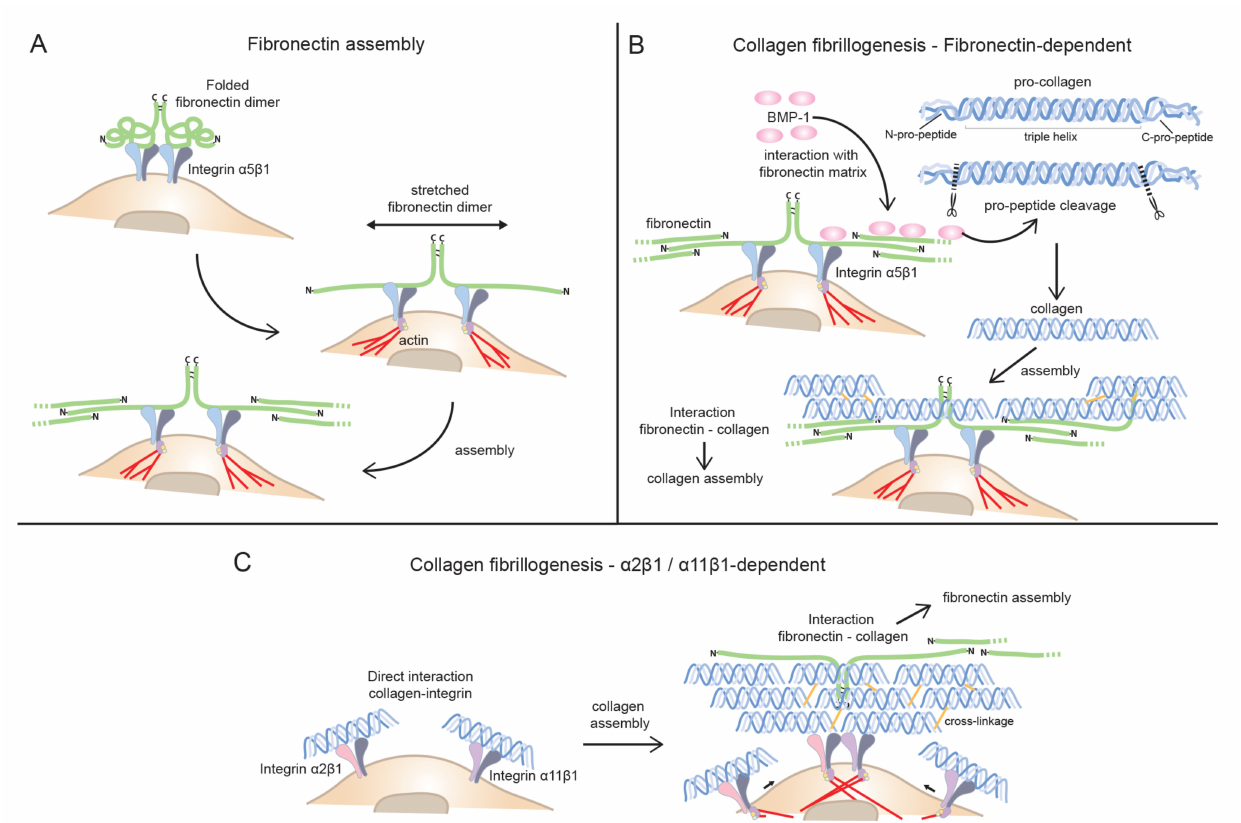
Figure 1. Collagen and fibronectin fibrillogenesis. ( A ) Fibronectin fibrillogenesis. Binding of fibronectin (FN) to the FN receptor α 5 β 1 integrin leads to a conformational change in FN exposing sites needed for fibril formation. The actin cytoskeleton exerts a pulling force on α 5 β 1 integrins to unfold FN. ( B ) Indirect mode of collagen assembly (fibronectin- dependent). Fibrillar collagens are secreted as pro-collagen. FN facilitates collagen assembly by concentrating BMP-1, which is involved in collagen pro-peptide cleavage. Collagen could then interact with FN matrix that serves as nucleator of collagen assembly. ( C ) Direct mode of collagen assembly (collagen-binding, integrin-dependent). The collagen-binding integrins α 2 β 1 and α 11 β 1 directly interact with collagen. They have been suggested to assist in collagen assembly. The FN and collagen matrix assembly are closely linked. These integrins might have a central role in the conditions where FN assembly is dependent on collagen